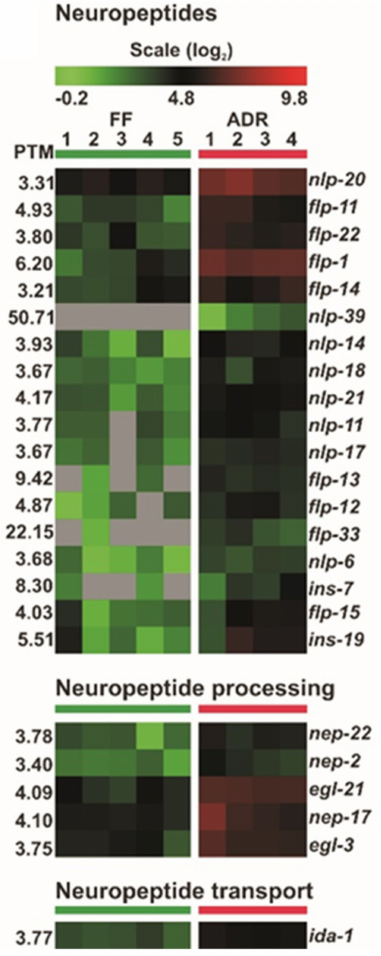
Figure 10. Differential expression of neuropeptide-related genes in worms under fully fed (FF) and axenic dietary restricted (ADR)